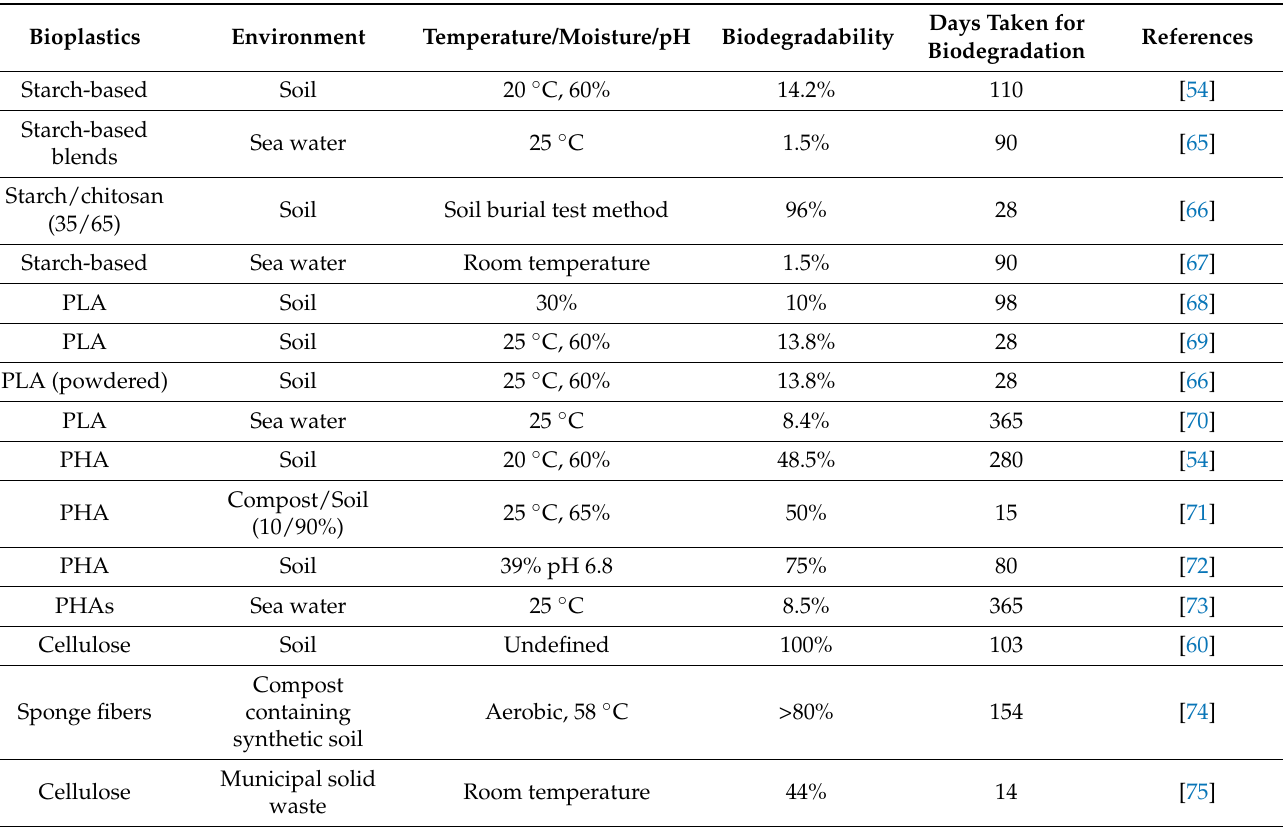
Table 1. Biodegradation of different types of bioplastics in soil and aquatic